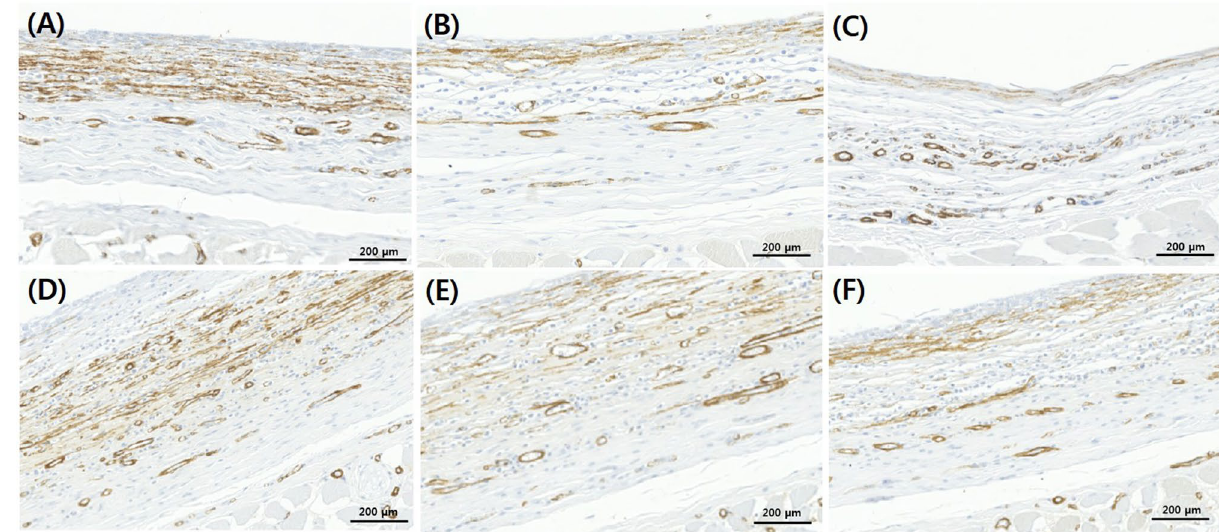
Figure 4. Immunohistochemical examination of myofibroblasts in the three different types of silicone implants. Representative immunohistochemistry sections of capsular tissues on the silicone implant (original magnification × 200). Sections were stained with anti-smooth muscle antibody antibody. ( A ) Group A (4 weeks, smooth type), ( B ) Group B (4 weeks, macrotexture type), ( C ) Group C (4 weeks, nanotexture type), ( D ) Group D (12 weeks, smooth type), ( E ) Group E (12 weeks, macrotexture type), ( F ) Group F (12 weeks, nanotexture type).